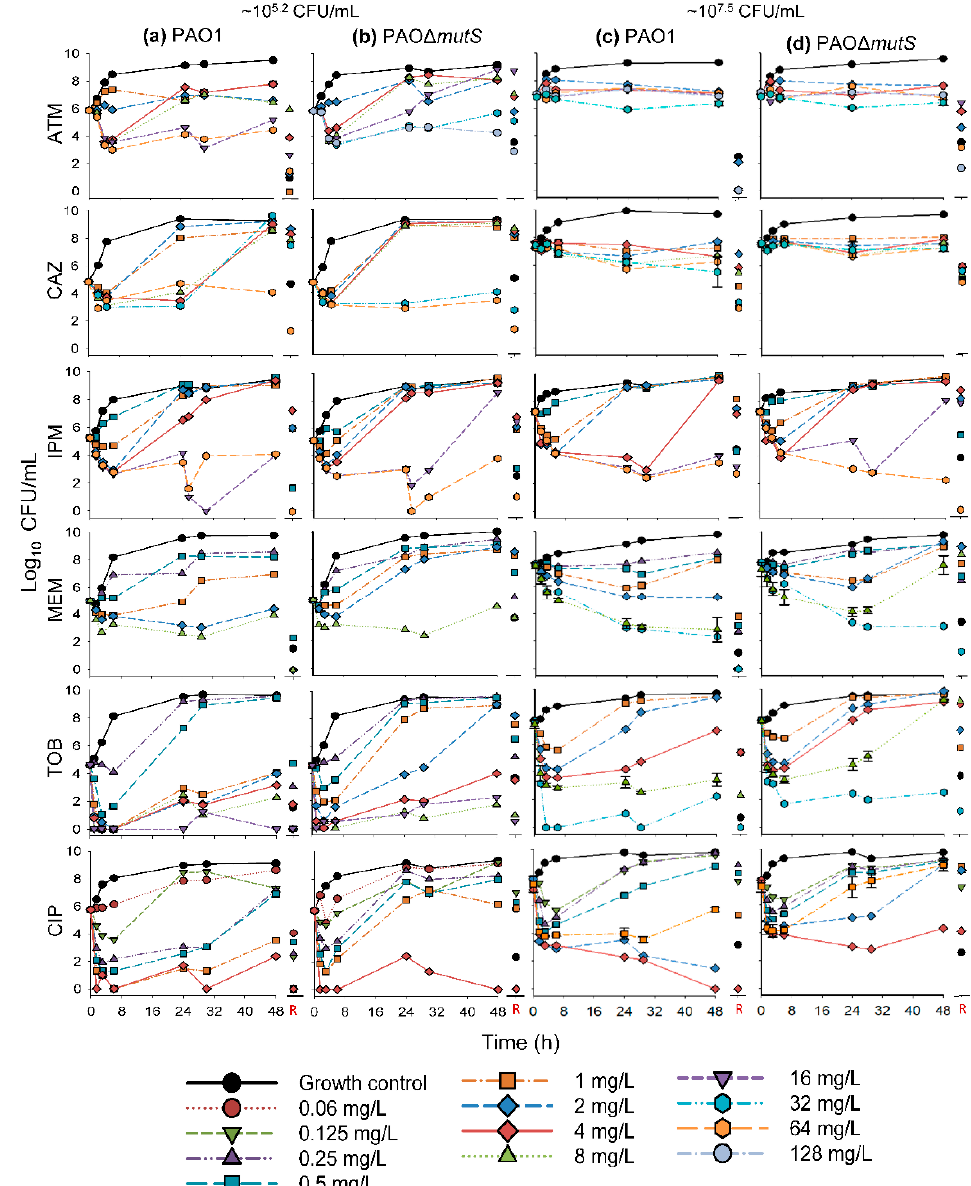
Figure 2. The log 10 viability counts (CFU/mL) of bacterial growth on antibiotic-free agar plates (total populations) versus time for non-hypermutable PAO1 and hypermutable PAO ∆ mutS exposed to aztreonam (ATM), ceftazidime (CAZ), imipenem (IPM), meropenem (MEM), tobramycin (TOB), and ciprofloxacin (CIP) in 48-h static concentration time-kill experiments at two initial inocula (lower ~10 5.2 CFU/mL on the left, ( a ) PAO1, ( b ) PAO ∆ mutS ,and higher ~10 7.5 CFU/mL on the right, ( c ) PAO1, ( d ) PAO ∆ mutS ). The following concentrations were studied against both inocula of each strain (unless denoted otherwise): aztreonam 1 a , 2, 4, 8 b , 16, 32 c,d , 64 a,d , and 128 c,d mg/L; ceftazidime 1, 2, 4, 8, 32, and 64 mg/L; imipenem 0.5, 1, 2, 4, 16, and 64 mg/L; meropenem 0.25, 0.5, 1, 2, 8, and 32 d mg/L; tobramycin 0.25 b , 0.5 b , 1, 2, 4, 8, 16 b , and 32 d mg/L; and ciprofloxacin 0.0625 b , 0.125, 0.25, 0.5, 1, 2 d , and 4 mg/L. The biological replicate studies for meropenem (8 mg/L), tobramycin (8 mg/L), and ciprofloxacin (1 mg/L) revealed significant differences ( p < 0.001, p < 0.01 and p < 0.001, respectively) between the two strains in the bacterial density at 48 h; see also Figure S1. R: denotes the bacterial population that grew on antibiotic-containing agar plates at 48 h. a Concentration was only used against the lower inoculum (10 5.2 CFU / mL) of PAO1. b Concentration was only used against the lower inoculum (10 5.2 CFU / mL) of both strains. c Concentration was only used against the lower inoculum (10 5.2 CFU / mL) of PAO ∆ mutS